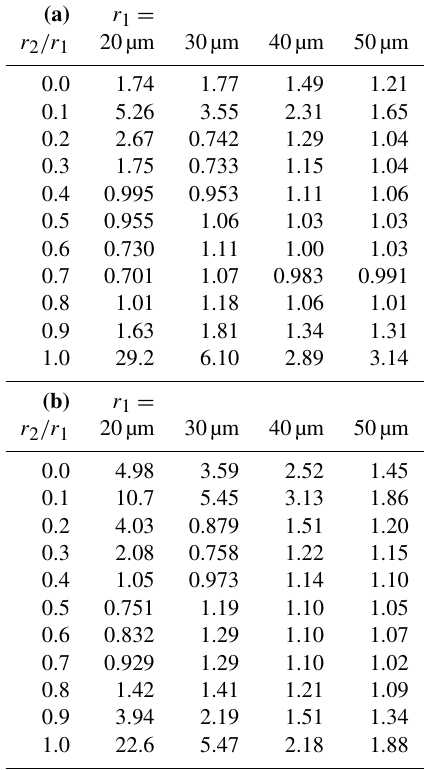
Table 2. Enhancement factor for the Pinsky collision effi- ciency (PKS01), η #PKS01 E , for (a) (cid:15) = 100cm 2 s − 3 and (b) (cid:15) = 400cm 2 s − 3